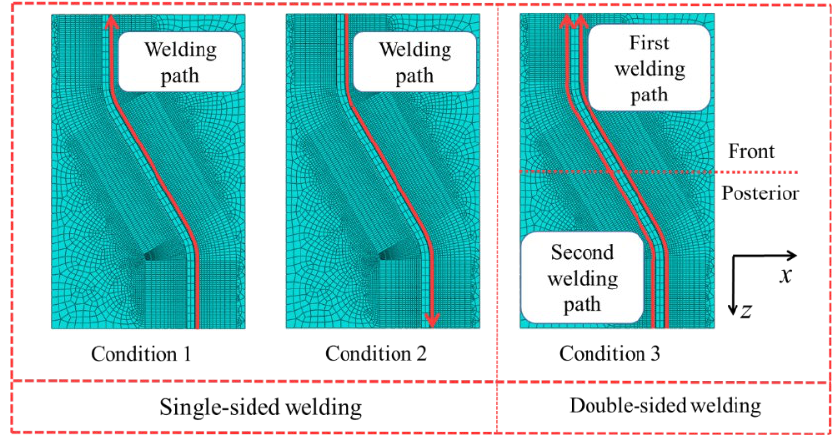
Figure 23. Welding condition diagram.